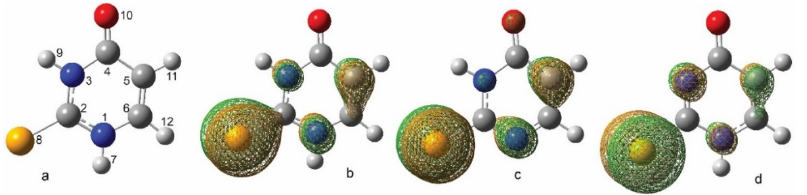
Figure 10. Optimized geometry of neutral and deprotonated 2-SeU in solution phase ( a , c , d ). HOMO of ( b ) neutral 2-SeU, ( c ) N 1 deprotonated, and ( d ) N 3 deprotonated 2-SeU (isocontour value = 0.04 a.u.).